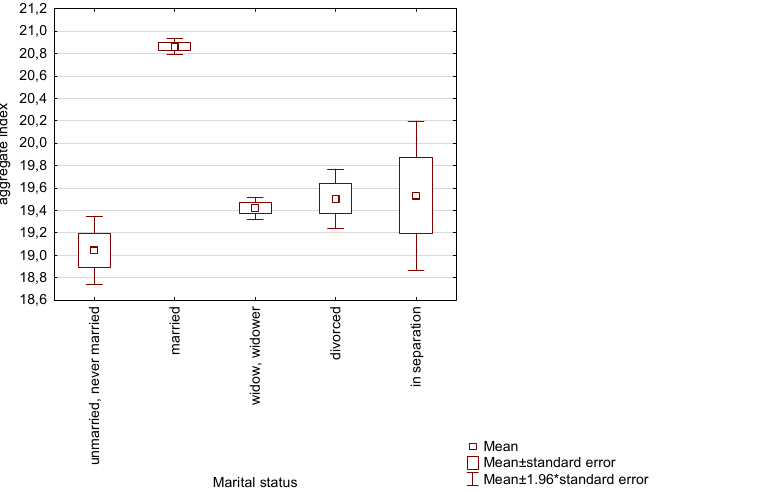
Figure 11. The level of the aggregate indicator in 2018 by marital status of a person representing the household of people aged 60 and older. Source: own elaboration based on data from [136].